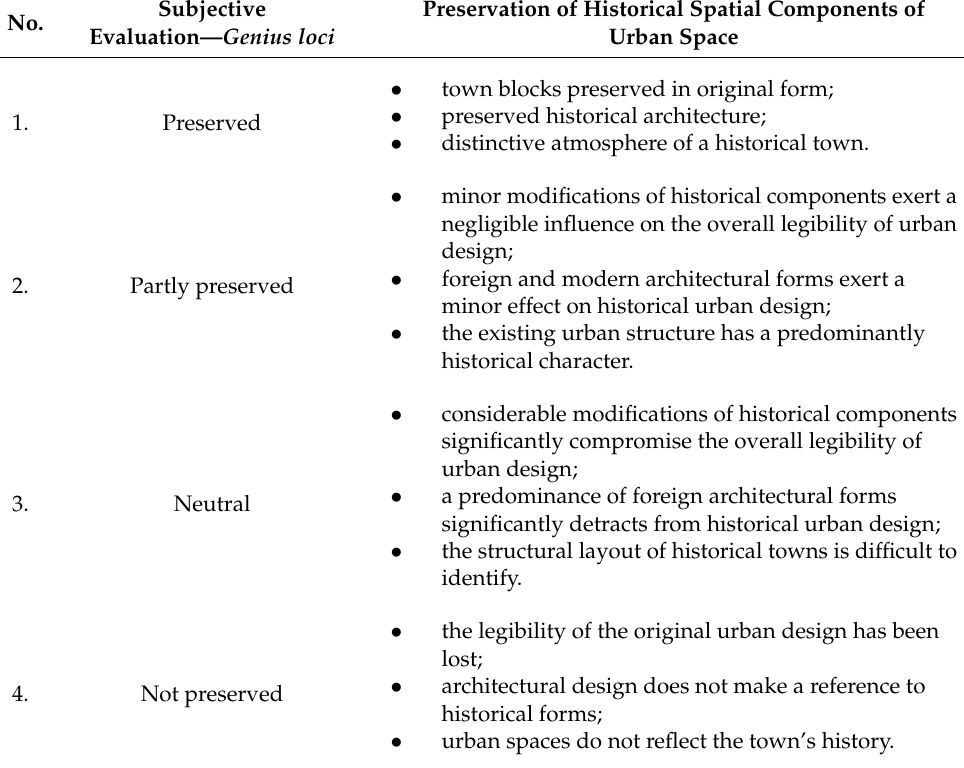
Table 9. Preservation of historical spatial components in the studied